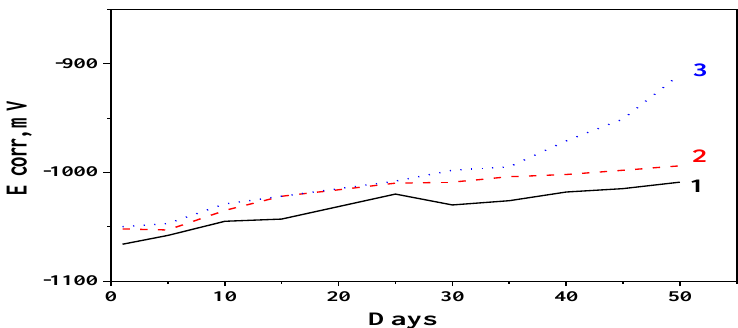
Figure 4. OCP data for ordinary Zn and both hybrid coatings: 1—Zn; 2—Zn-PANI / PVP; 3—Zn-PANI / SiO 2 .